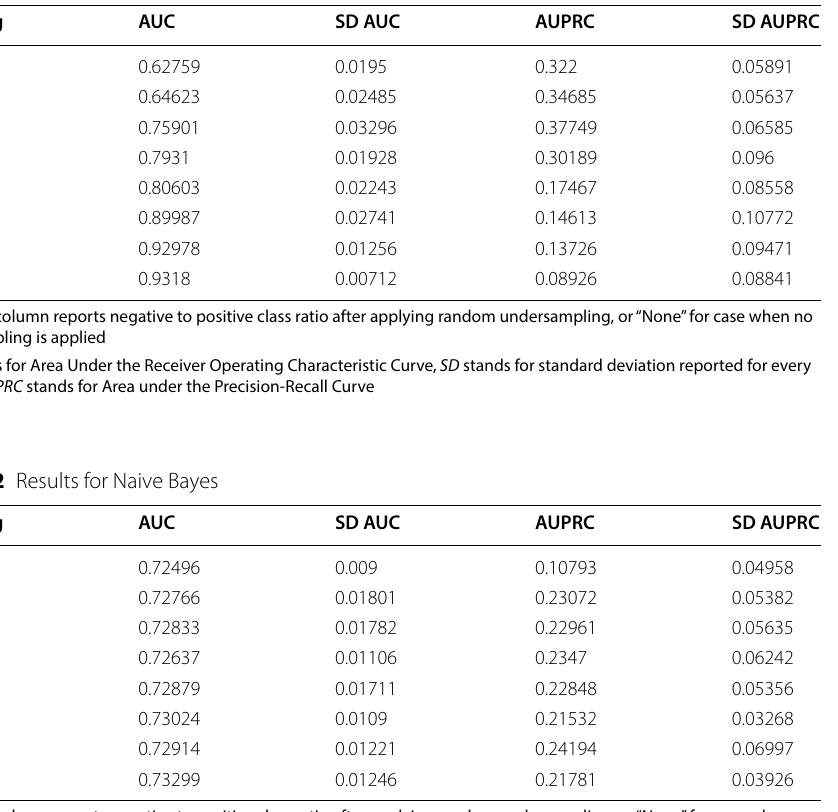
Table 11 Results for CatBoost